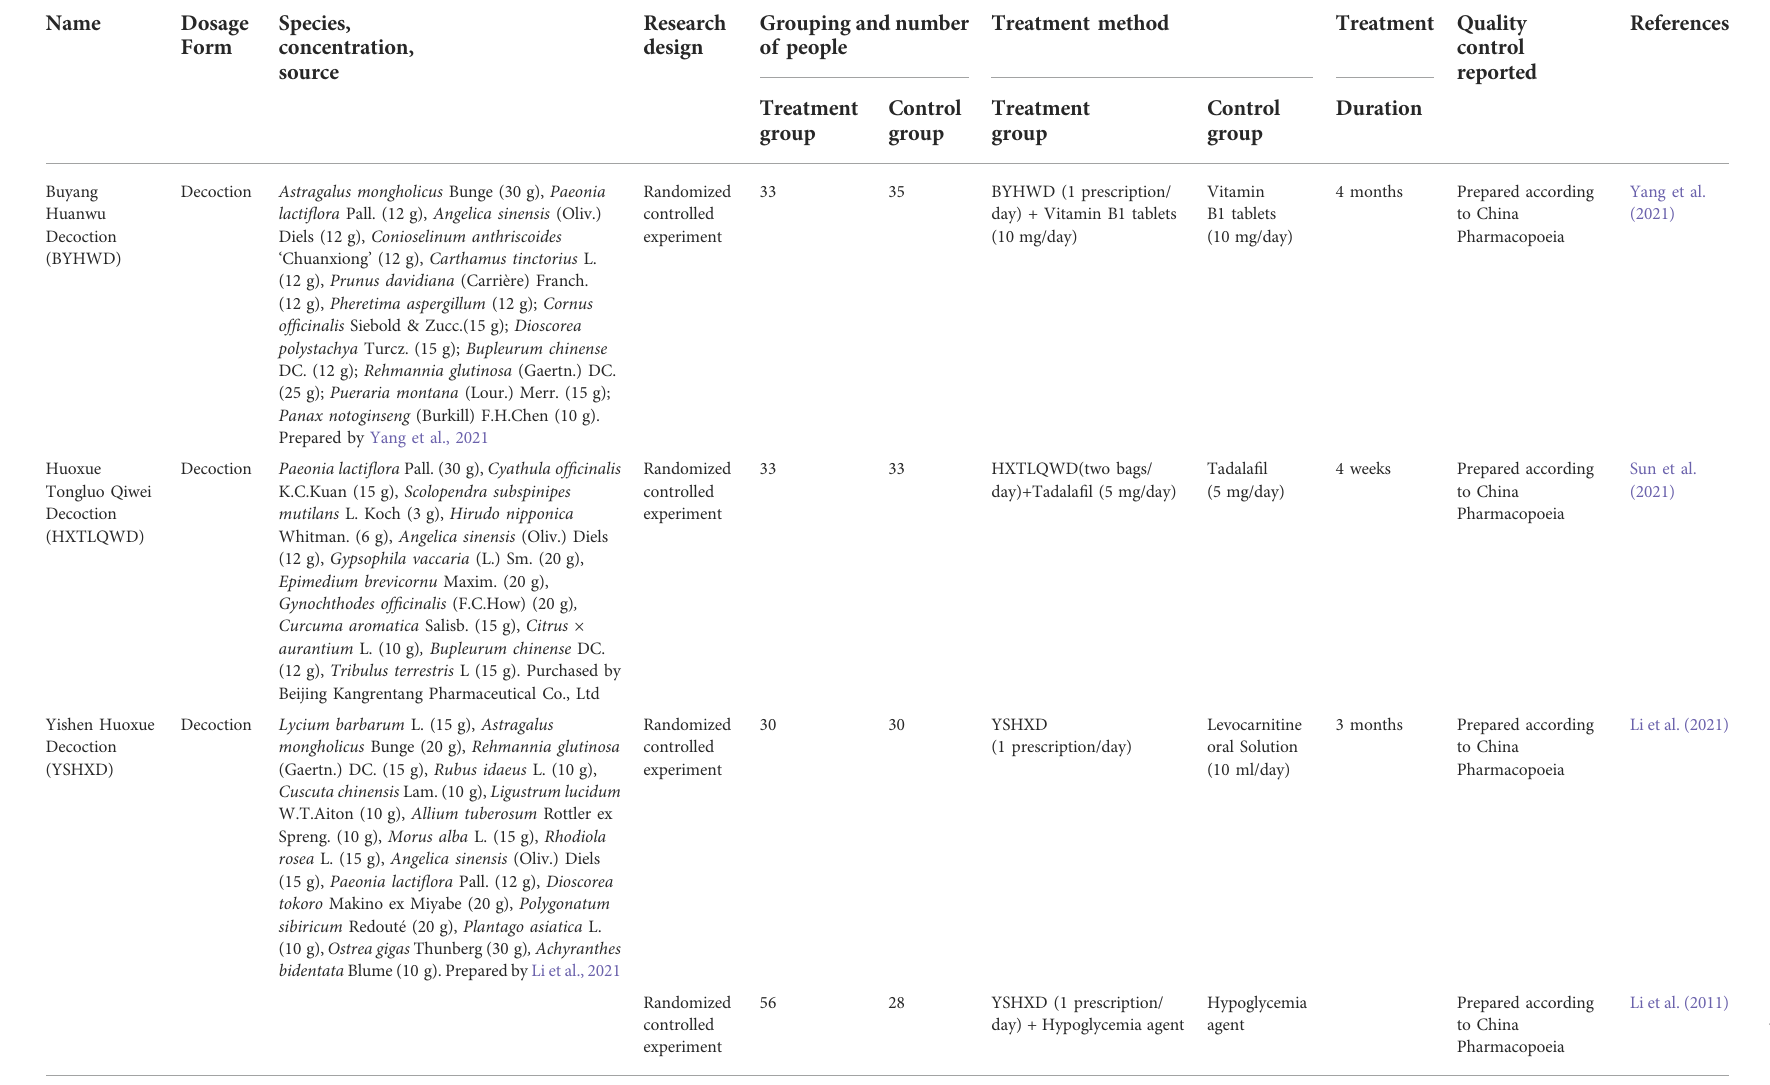
TABLE 1 Summary of the prescribed formulae and natural products from Traditional Chinese medicine used in clinical